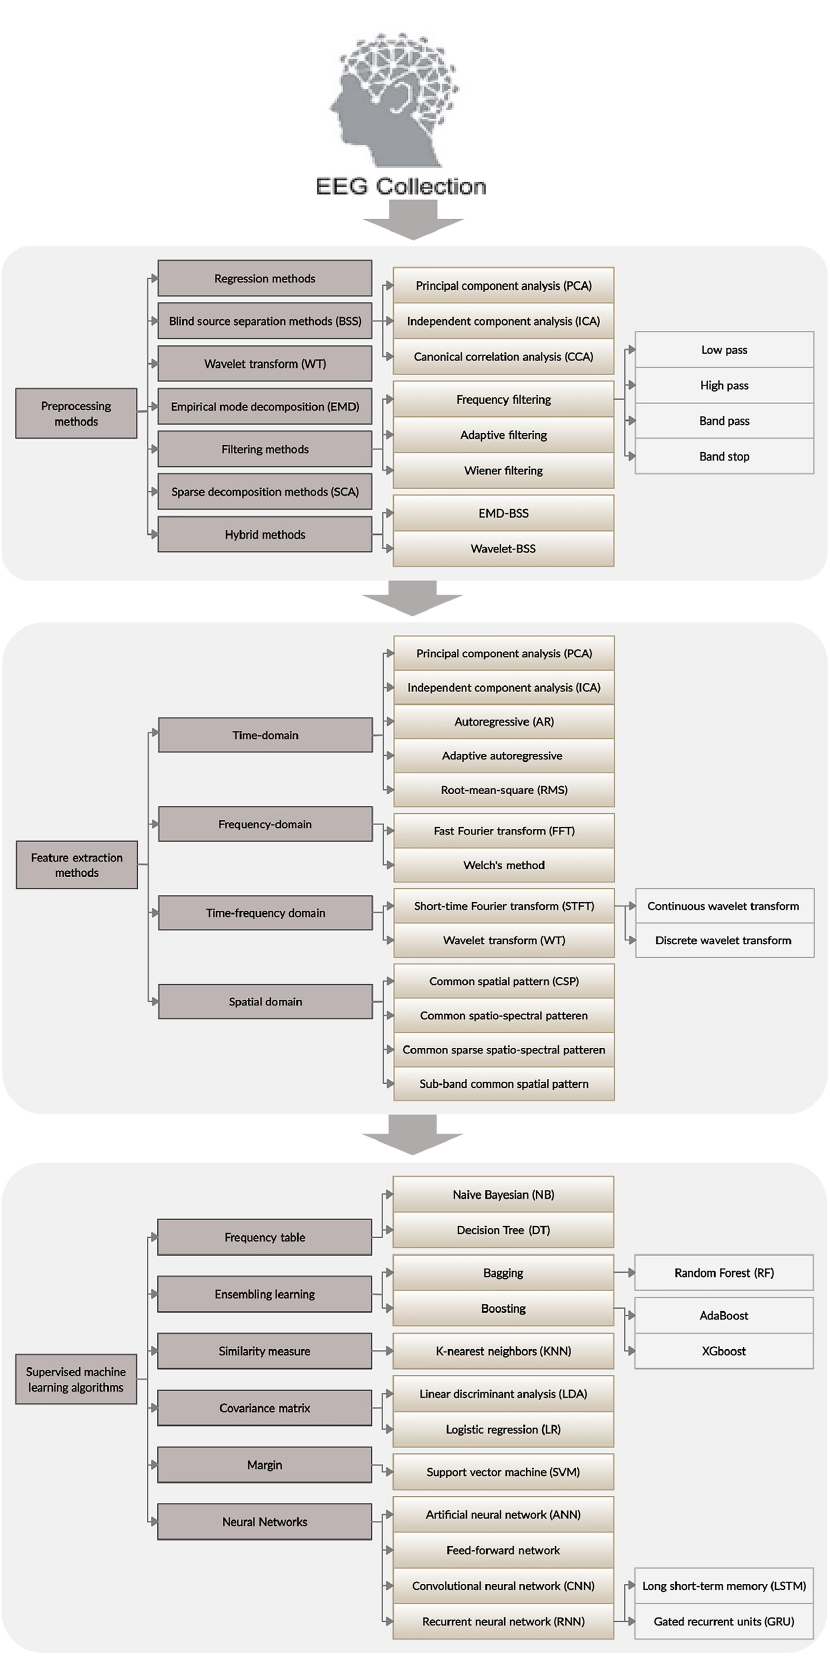
Figure 1. Flow chart of the EEG data analysis pipeline along with taxonomy of existing methods for each